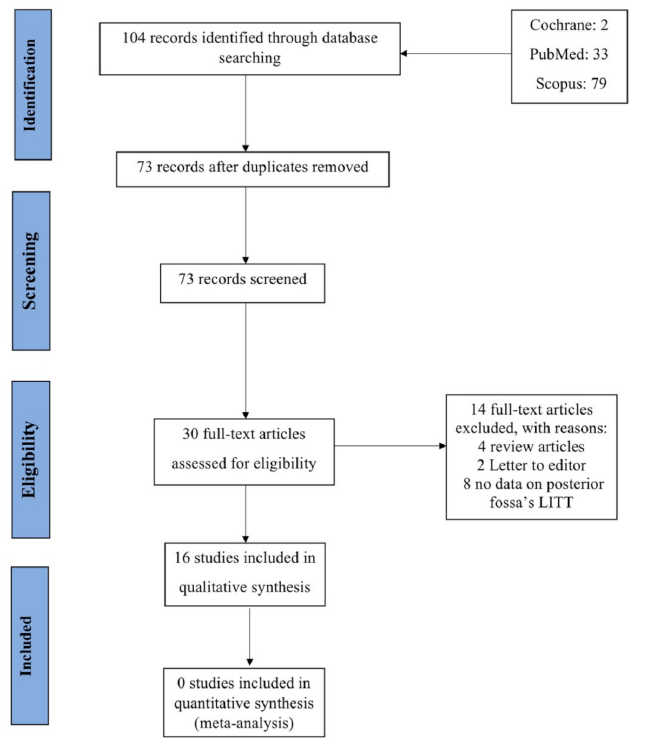
Figure 1. Preferred Reporting Items for Systematic Reviews and Meta-Analyses (PRISMA) diagram of included